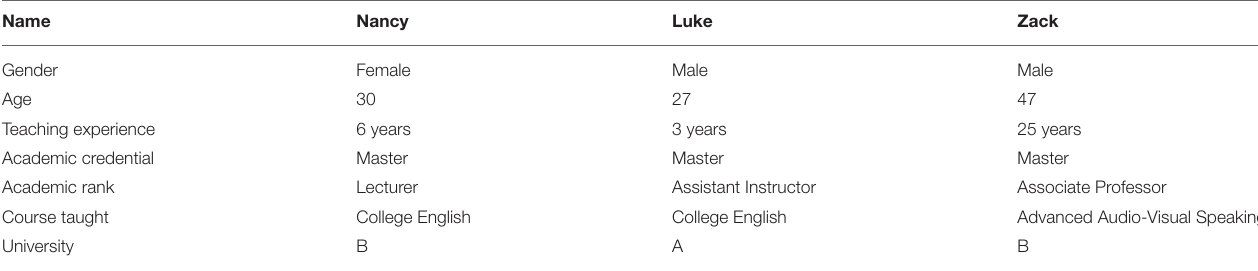
TABLE 1 | Demographic information of the three teacher